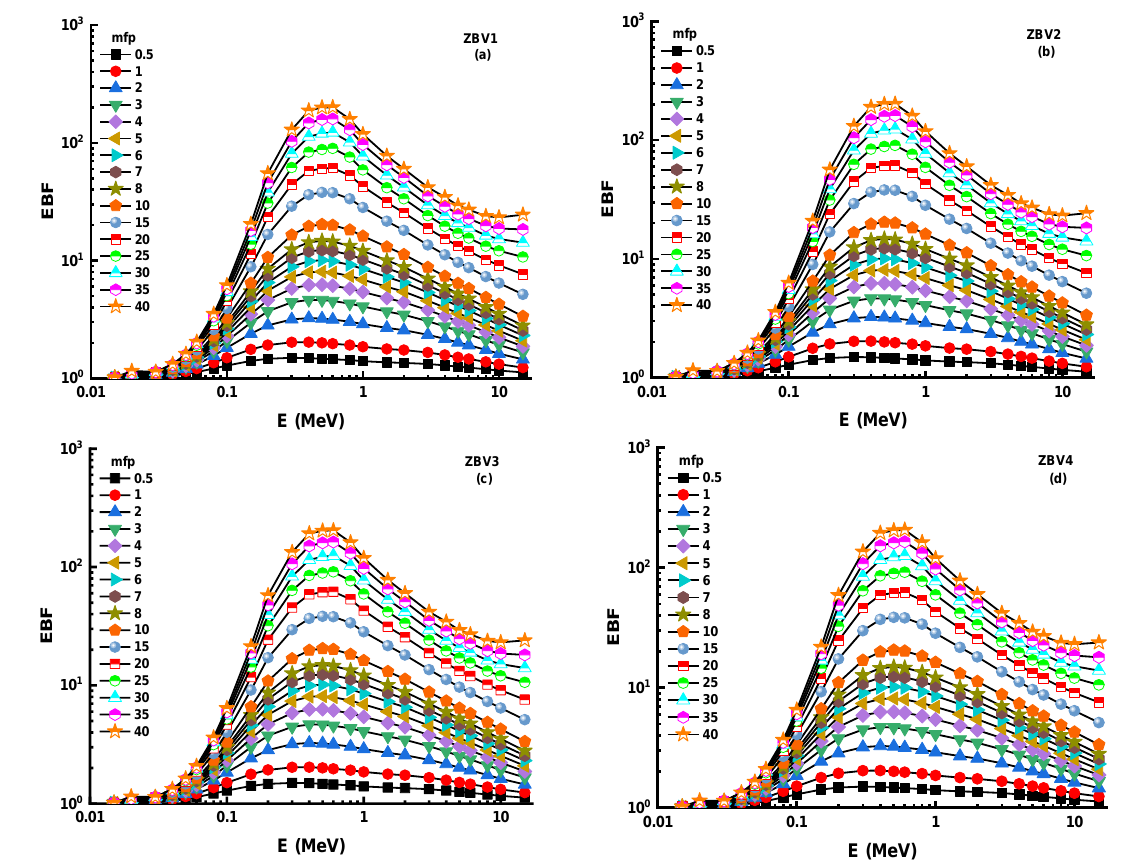
Figure 9. ( a – d ): Variation of exposure buildup factor (EBF) against photon energy for all glasses. Figures 11 and 12 show the differing energy-absorption buildup factors (EABF) and exposure buildup factors (EBF) at 0.4 MeV along with 10, 20, 30, and 40 mfp values for all glasses. It can be seen that the ZBV1 sample showed the minimum EBF and EABF values at the studied mfp values. From ZBV1 to ZBV4, EBF and EABF values showed an increasing trend. This can be explained by decreasing gamma-ray-attenuation competencies with a V 2 O 5 reinforcement amount from 1 to 4 mol.%. As a last analysis of EBF and EABF values, Figure 13 shows the variations in the energy-absorption buildup factor (EABF) and exposure buildup factor (EBF) against effective atomic number (Z eff ) for all glasses at 1 MeV/5 mfp. This is another sign of the synergistic effect of V 2 O 5 reinforcement, which caused a decrement in densities of glasses, and in gamma-ray-shielding competencies accordingly. As illustrated in Figure 13, EBF values increased gradually from ZBV1 to ZBV4. This trend was a natural consequence of variations in effective atomic numbers, which was discussed in previous